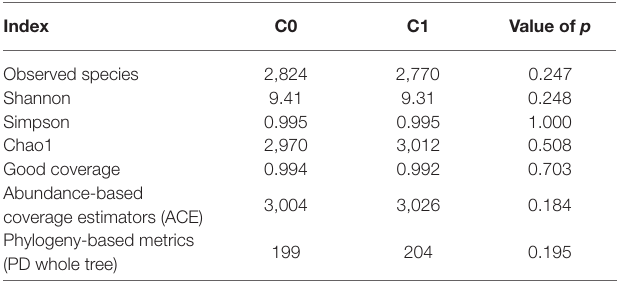
TABLE 1 | Soil bacterial community diversity and richness for rice plants grown with biochar application (C1) and those grown without biochar application